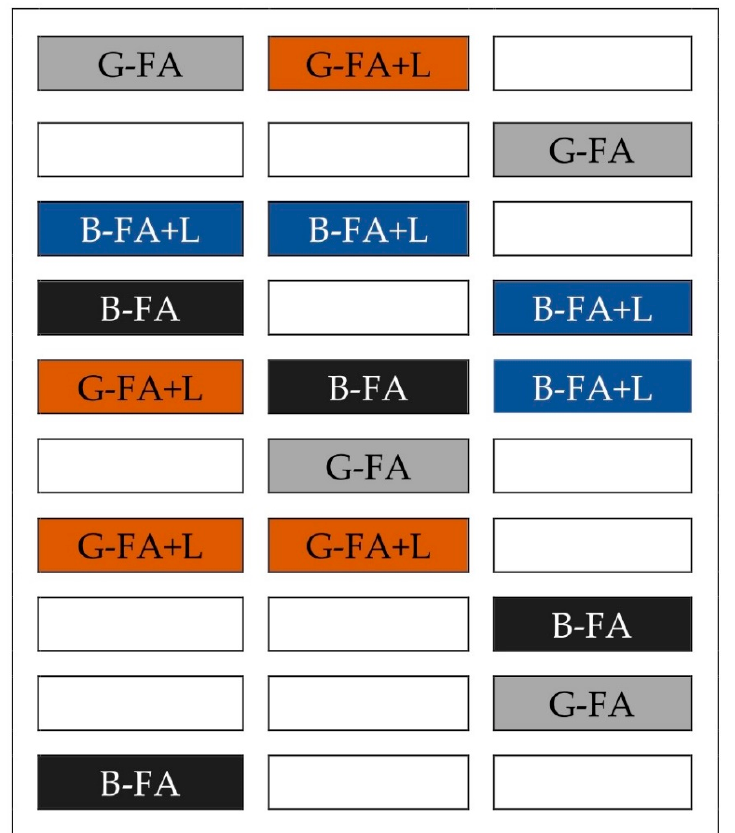
Figure 2. Conceptual model of the alder species experiment on the Lubie´n combustion waste disposal site. B-FA—black alder planted in pure combustion waste; G-FA—grey alder planted in pure combustion waste, B-FA + L—black alder planted in combustion waste with lignite addition in planting holes, G-FA + L—grey alder planted in combustion waste with lignite addition. In empty places represent plots with green alder and Miocene sand amendments not included in this study.